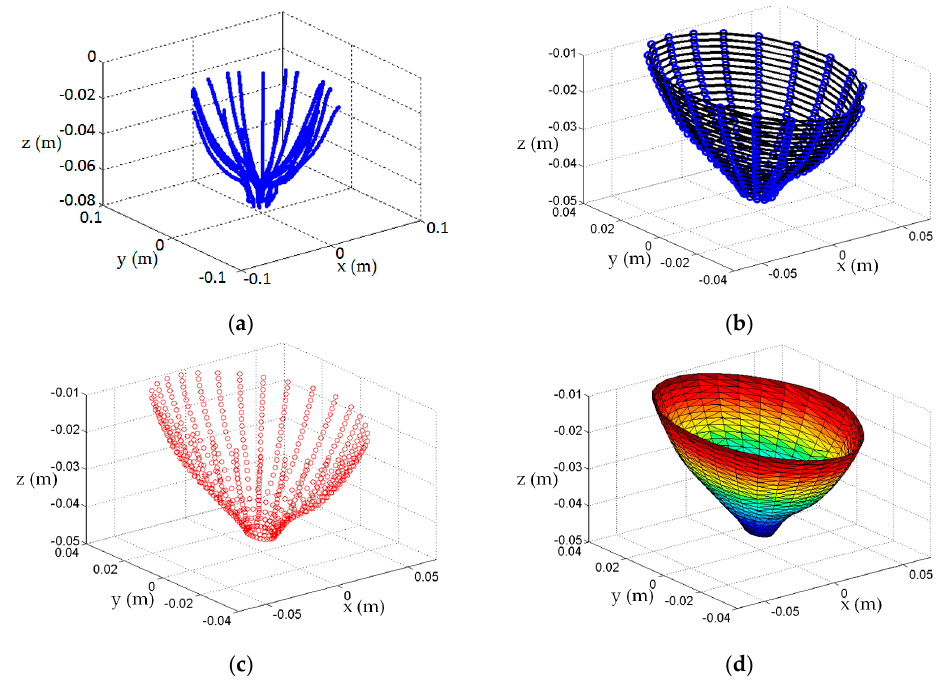
Figure 3. Sequence of steps to construct breast surface of patient: ( a ) Laser measurements, ( b ) 20 profiles estimated from the laser data are sampled (blue dots) at 22 different heights. For each height, a contour (black curve) is formed from the 20 profile samples to form 22 contours; ( c ) Points on contour are preprocessed to remove any self-intersecting curves, interpolating points are calculated between points, and splines fit the data to form a smooth model of contour. Contours are uniformly sampled to form a cloud of points (red dots), ˆP S , that estimate the surface; ( d ) Tessellated surface model of breast formed from surface samples.